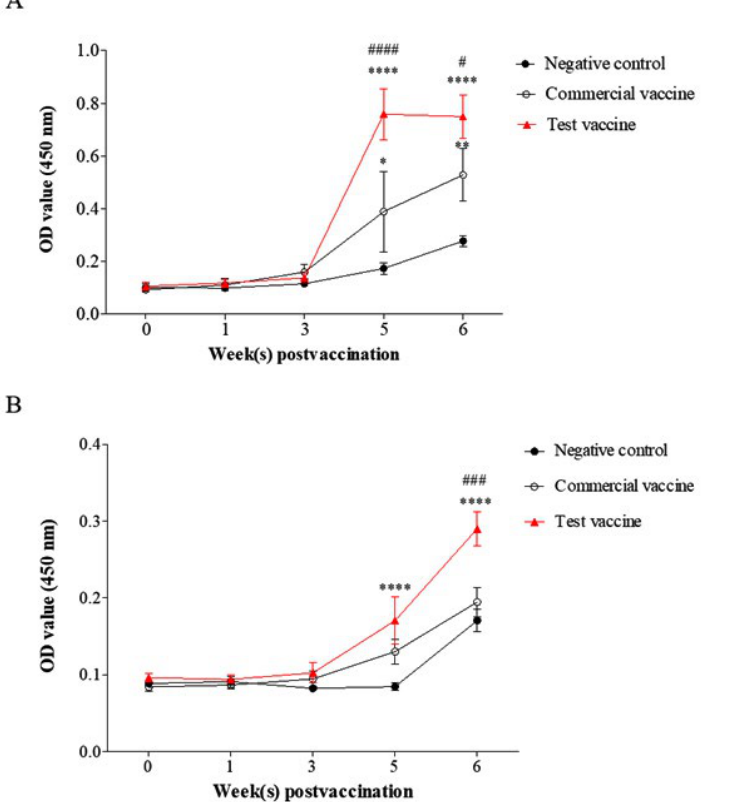
Fig. 3. Specific antibody responses against 42 kDa OMP (A) and Apx toxoids (B) in the test vaccine ( ▲ ), the commercial vaccine (o), and the negative control groups (•). Data are presented as means ± SD. The asterisks and hashes indicate significant differences (* p < 0.05; ** p < 0.01; **** p < 0.001, compared with the negative control group. # p < 0.05; ###, #### p < 0.001, compared with the commercial vaccine group). OD value (450 nm), absorbance at 450